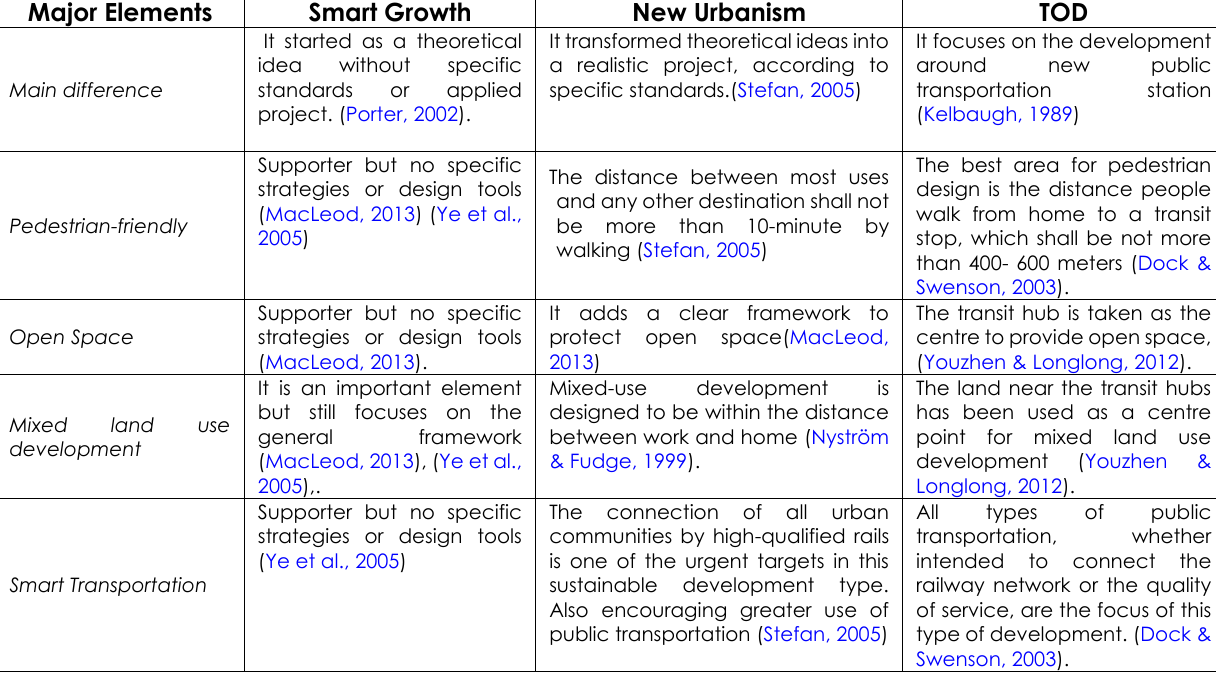
Figure 3. Designation for TOD area around Transit Stop – The Authors based on (Dock & Swenson, 2003). Table 1. comparison between sustainable development theories (The Authors based on various sources as detailed